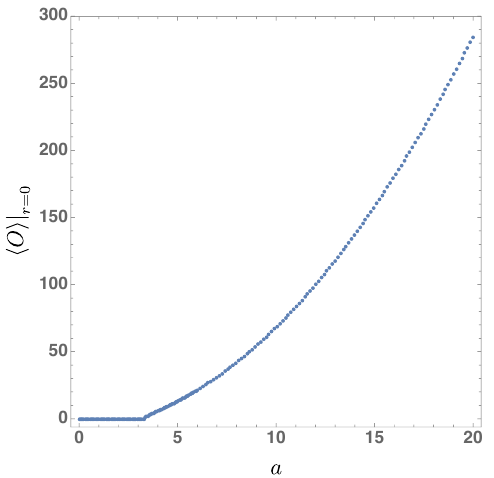
Figure 4 . Central value of expectation value of the operator dual to (cid:8) as a function of the boundary p amplitude a for (cid:11) = 3. The condensation occurs around a (cid:24) 3 : 33, in accordance with the linear results. There is no maximum amplitude.